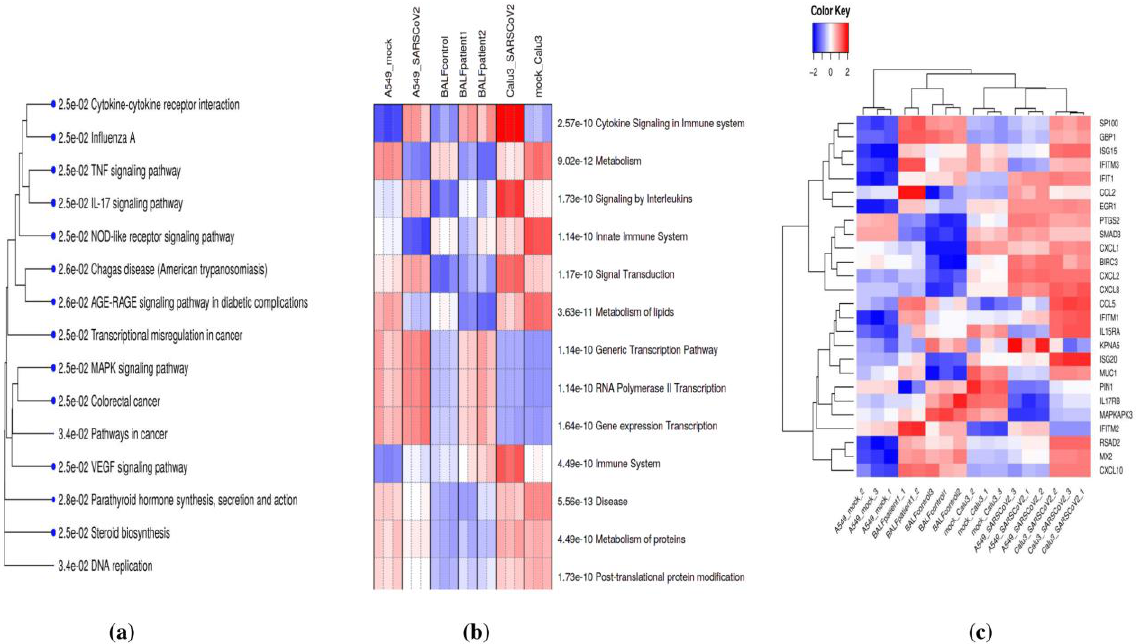
Figure 3. ( a ) Pathway enrichment analysis of common differentially expressed (DE) genes using the KEGG database. ( b ) Parametric Gene Set Enrichment Analysis (PGSEA) analysis of common DE genes using the Reactome database. Red and blue indicate activated and suppressed pathways, respectively. ( c ) Patterns of expression of genes involved in cytokine signaling in the immune system in SARS-CoV-2-infected and control datasets.